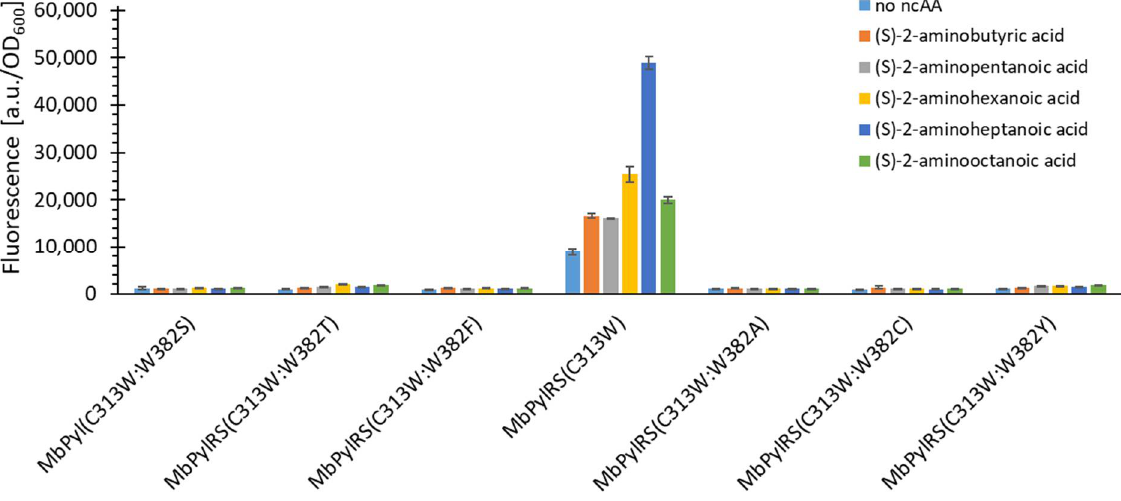
Figure 4. Comparison of the efficiency of aliphatic ncAA incorporation for Mb PylRS(C313W) constructs mutated at position W382. The fluorescence was measured for intact E. coli BL21(DE3) cells producing the SUMO-sfGFP(R2amber) reporter protein. The data (incl. standard deviation) represent the mean of three biological replicates.